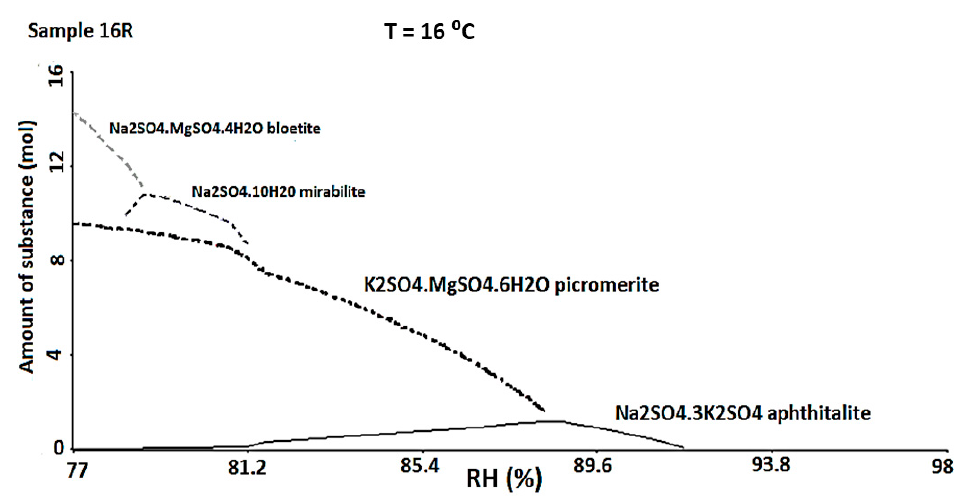
Figure 7. ECOS-RUNSALT output (16 °C, RH 98–77%) for the sample 16R in which is possible to observe the formation of different sulphates.